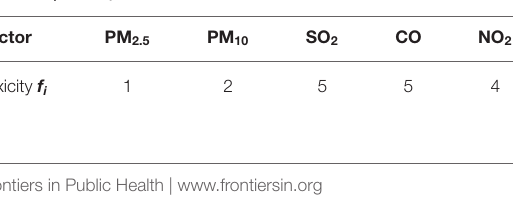
TABLE 1 | Toxicity index f i of each factor.